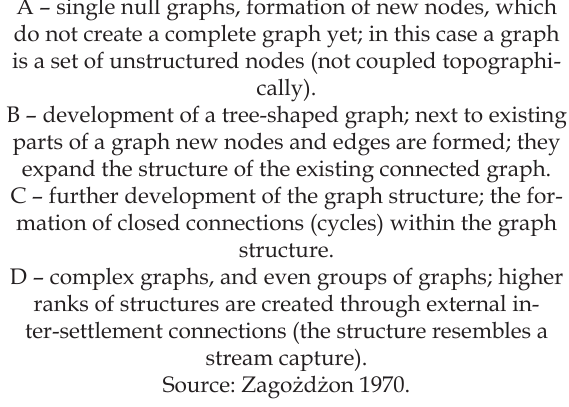
Fig. 2. Shaping stages of a graph